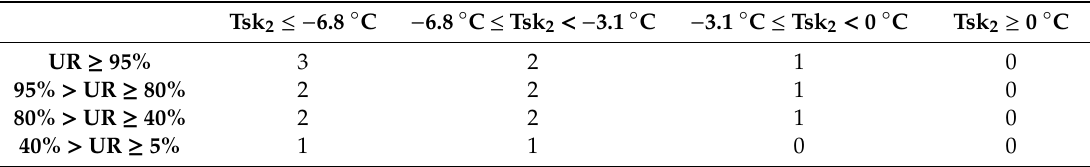
Table 4. Ice Alert code